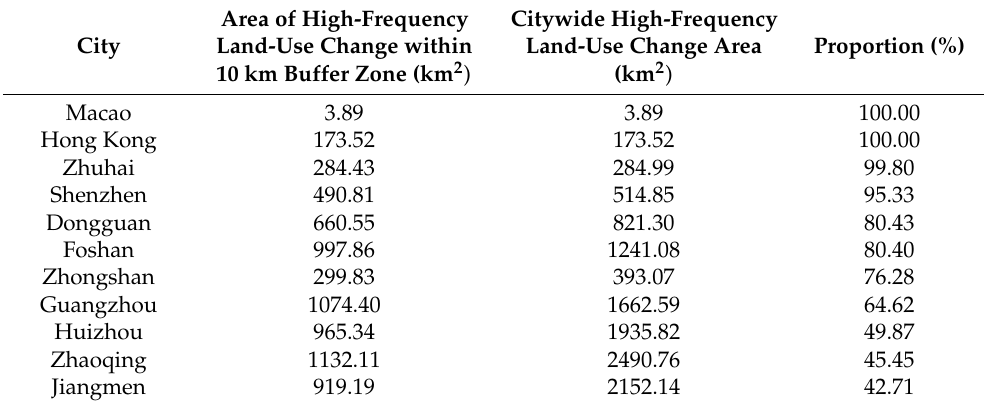
Figure 7. Area and percentage of frequency of land-use change within a 10 km buffer zone of prefecture-level municipal administrative districts. Table 5. Area and proportion of land-use-change frequency within a 10 km buffer zone of prefecture- level municipal administrative